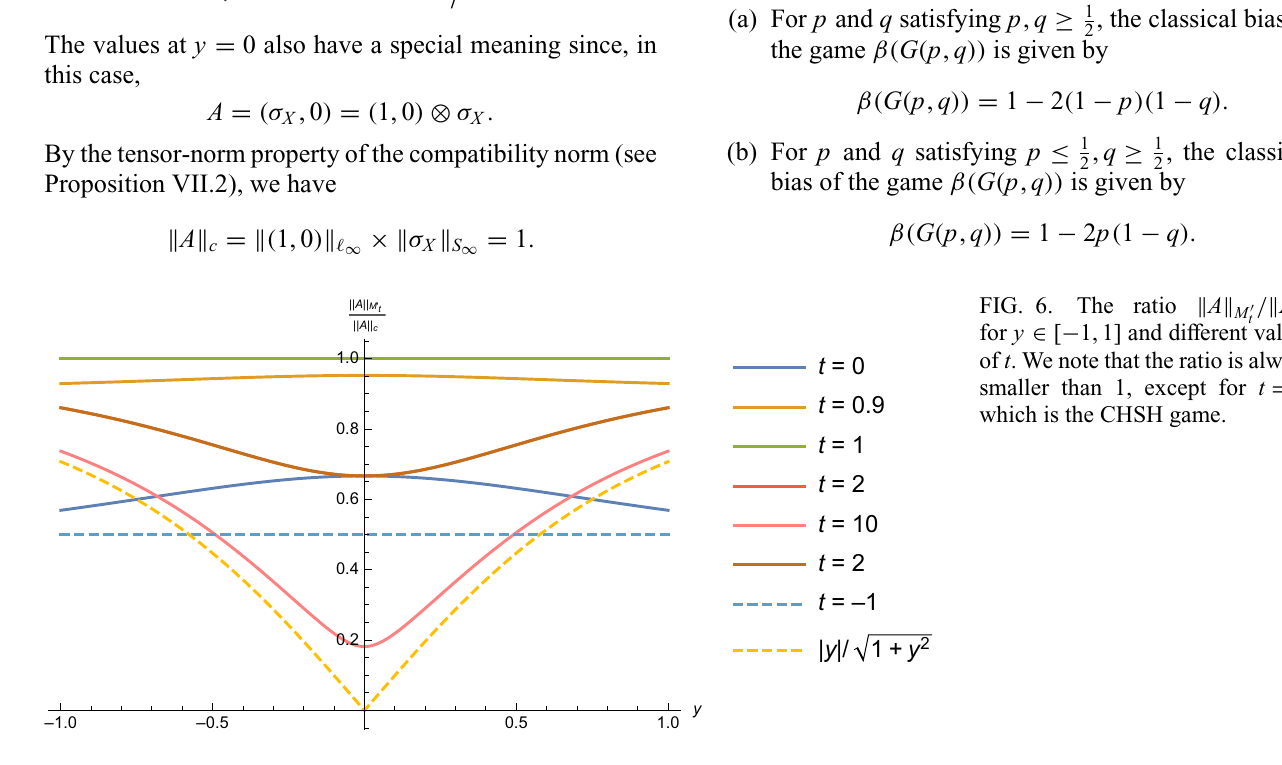
FIG. 6. The ratio (cid:2) A (cid:2) for y ∈ [ − 1, 1] and different values of t . We note that the ratio is always smaller than 1, except for t = 1, which is the CHSH